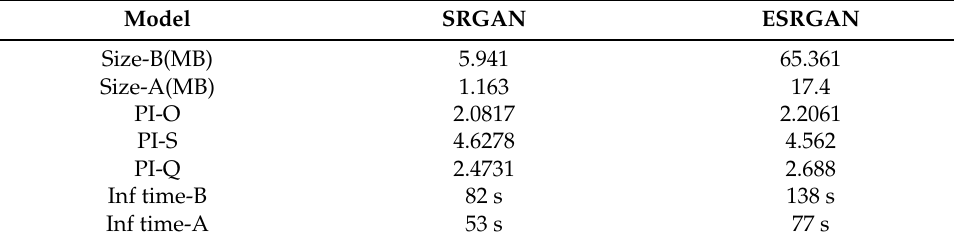
Table 2. Quantized results of ESRGAN and SRGAN